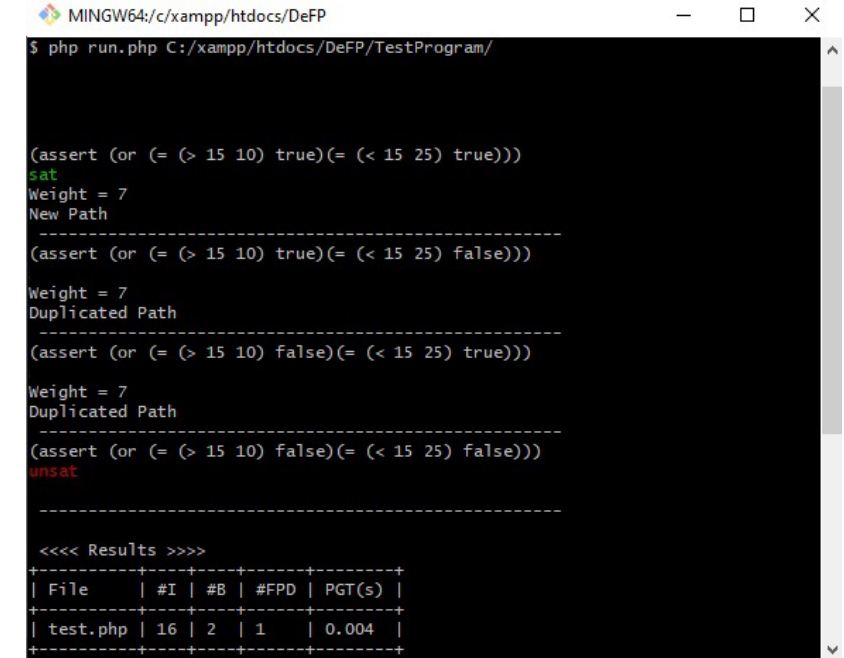
Figure 8. The satisfiability results of the program in Figure 1 using Z3